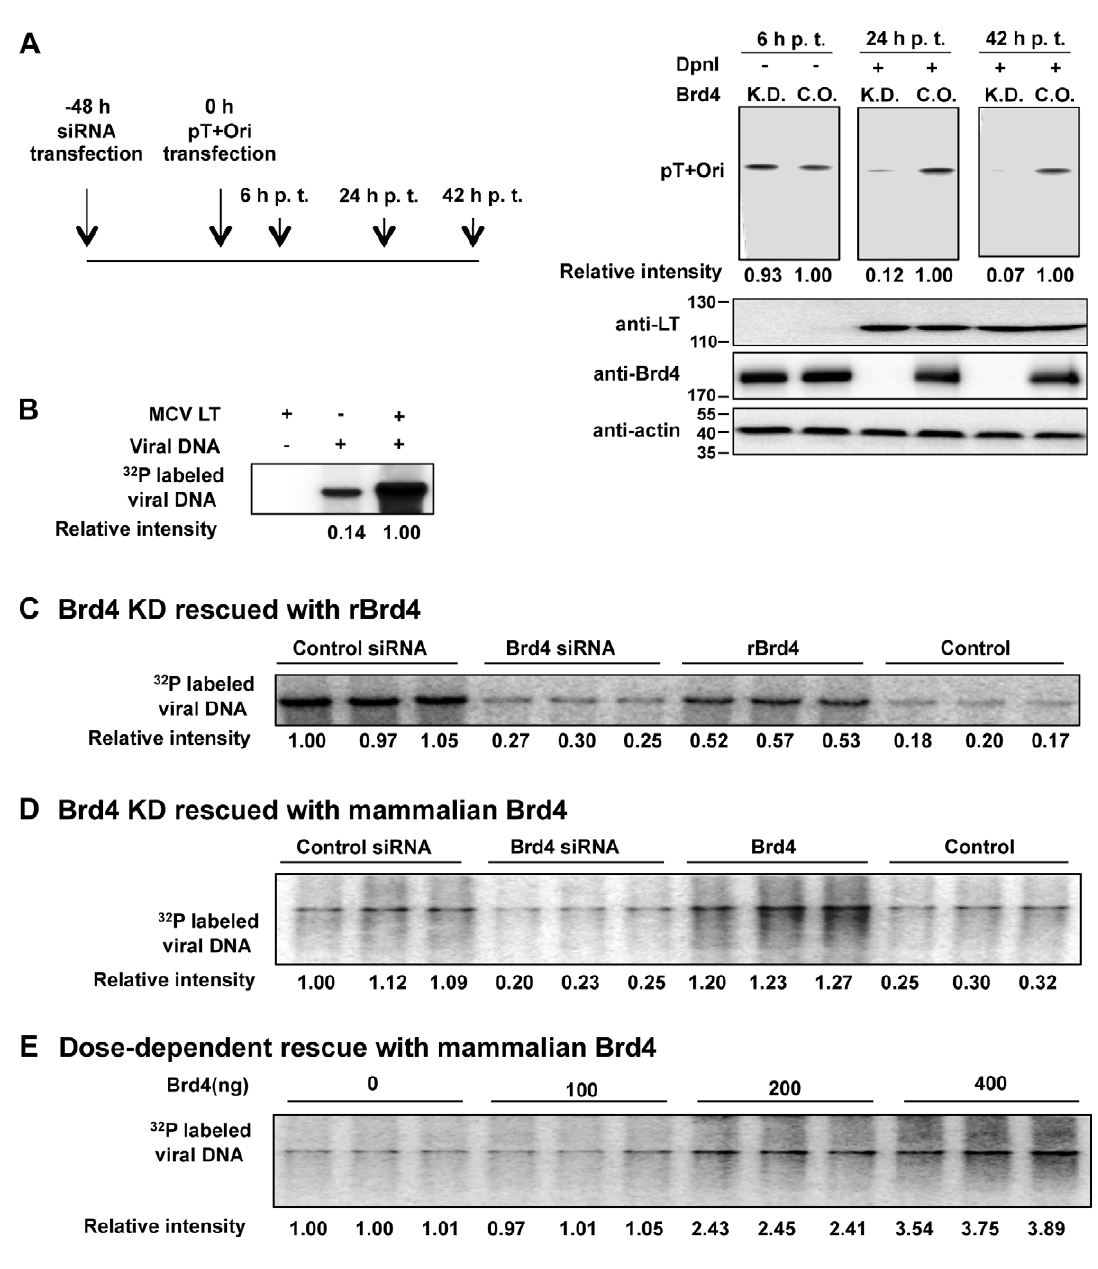
Figure 2. Brd4 is important for MCV DNA replication. A . Brd4 knockdown inhibits MCV replication in vivo . C33A cells were transfected with either a siRNA targeting Brd4 (K.D.) or a non-targeting siRNA control (C.O.). Forty-eight h later, cells were transfected with pT + Ori and this time was set as 0 h. Total DNA was extracted at 6, 24 and 42 h p.t.; 2 m g of the DNA samples from 6 h p.t. were digested with EcoRI and plasmid DNA was detected by Southern blotting. 10 m g of the DNA samples from 24 and 42 h p.t. were digested with both EcoRI and DpnI to specifically detect replicated plasmid. Protein extracts were immunoblotted for MCV LT, Brd4 and actin. B . MCV LT-dependent in vitro replication of MCV genome. In vitro MCV replication was performed using full length MCV genomic DNA and cell extracts prepared from 293T cells transfected with either pcDNA4C- MCV LT or pcDNA4C. C . Brd4 knockdown inhibits viral DNA synthesis in vitro and the inhibition can be rescued by recombinant Brd4. 293T cells were transfected with a Brd4 siRNA or a control siRNA. At 40 h p.t., cells were re-transfected with pcDNA4C-MCV LT. Cell extracts were prepared at 88 h p.t. and used for in vitro replication of MCV DNA. In the ‘‘rBrd4’’ condition, 3 m g His-Brd4 purified from insect cells using nickel resin was added to the Brd4 knockdown extract prior to performing the replication assay. In the ‘‘Control’’ condition, an equal amount of nonspecific proteins eluted from the nickel resin incubated with insect cells carrying wild-type baculovirus were used. All reactions were performed in triplicates. Immunoblots of cell extracts used in the assay and His-Brd4 purified from insect cells are shown in Fig. S3B and S3C. D . Brd4 knockdown inhibits MCV DNA replication in vitro and the inhibition can be rescued by Brd4 purified from mammalian cells. Extracts from cells transfected with a Brd4 siRNA and pcDNA4C-MCV LT as described in C were used in the in vitro replication assay. In the ‘‘Brd4’’ condition, 400 ng Brd4 purified from 293T cells was added to the Brd4 knockdown extract prior to performing the replication assay. In the ‘‘Control’’ condition, an equal amount of nonspecific proteins isolated from the vector control cells were used. All reactions were performed in triplicates. Coomassie Brilliant Blue staining of Brd4 purified from 293T cells are shown in Fig. S3E. E . Dose-dependent rescue of in vitro viral replication by the purified Brd4 protein. Extracts from cells transfected with a Brd4 siRNA and pcDNA4C-MCV LT as described in C were used in the in vitro replication assay. Increasing amounts of purified Brd4 was added to the reactions. All reactions were performed in triplicates.